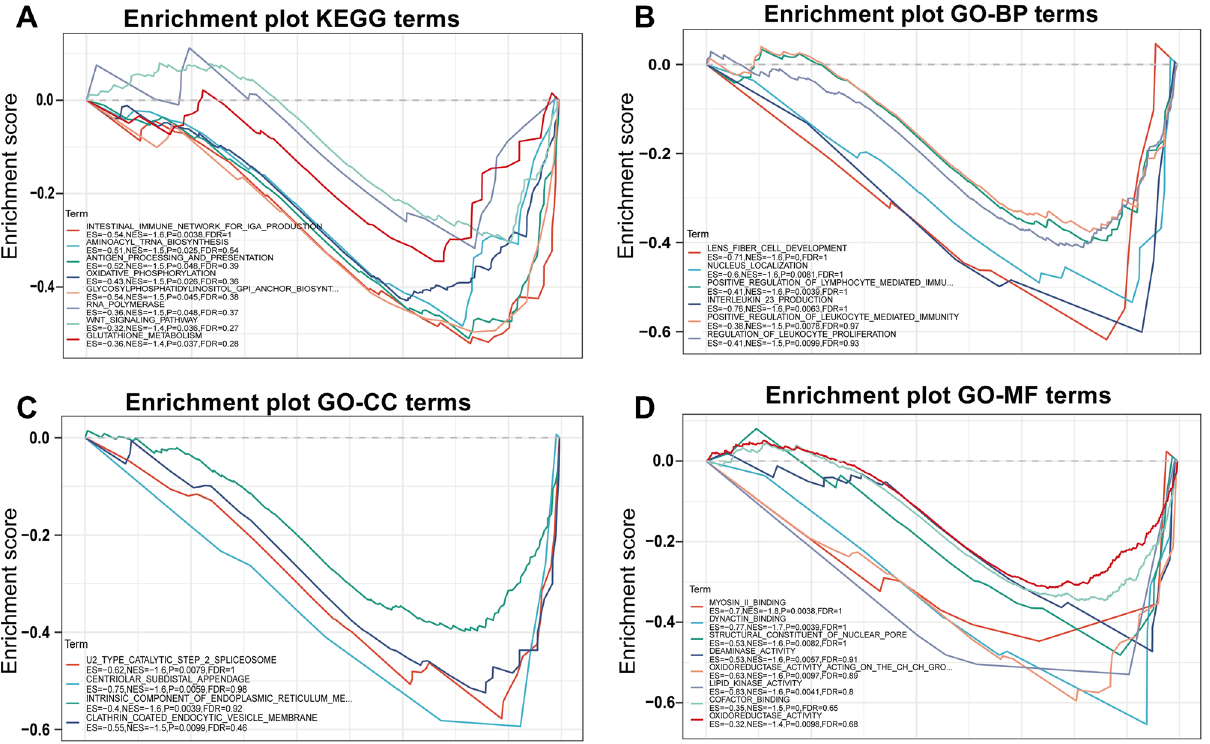
Figure 8. Gene set enrichment analysis (GSEA) of the TIMELESS gene. ( A ) KEGG pathway terms. ( B ) GO term of biological process. ( C ) GO term of cell component. ( D ) GO term of molecular function. The color of the line represents the term for the gene function, and Y-axis represents the enrichment score.